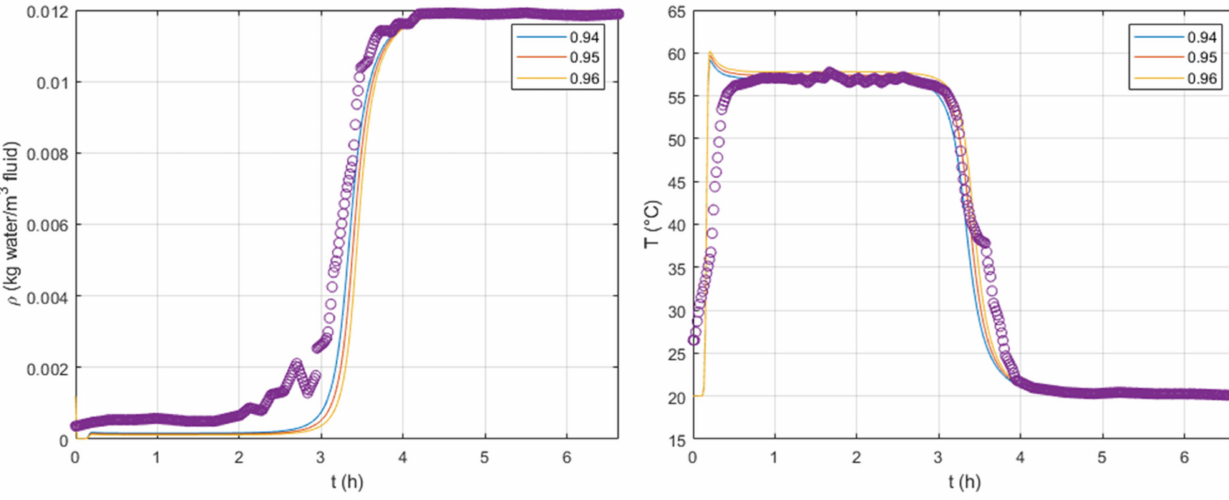
Figure 5. Sensitivity analysis of the heat of adsorption, ∆ H ads , onto concentration and temperature profiles. Experimental data with the symbol and simulated response in (cid:35)